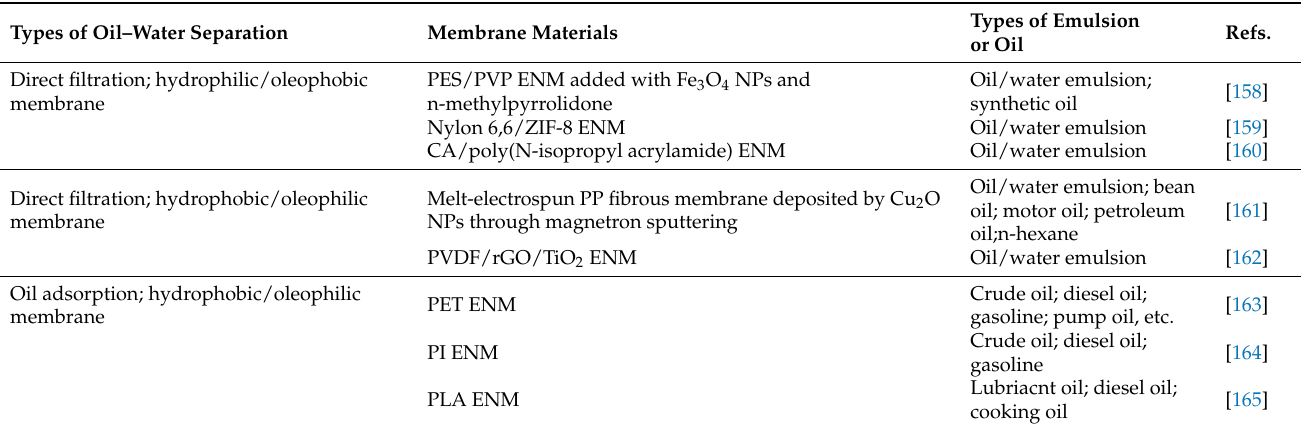
Table 4. Several studies on oil–water separation based on